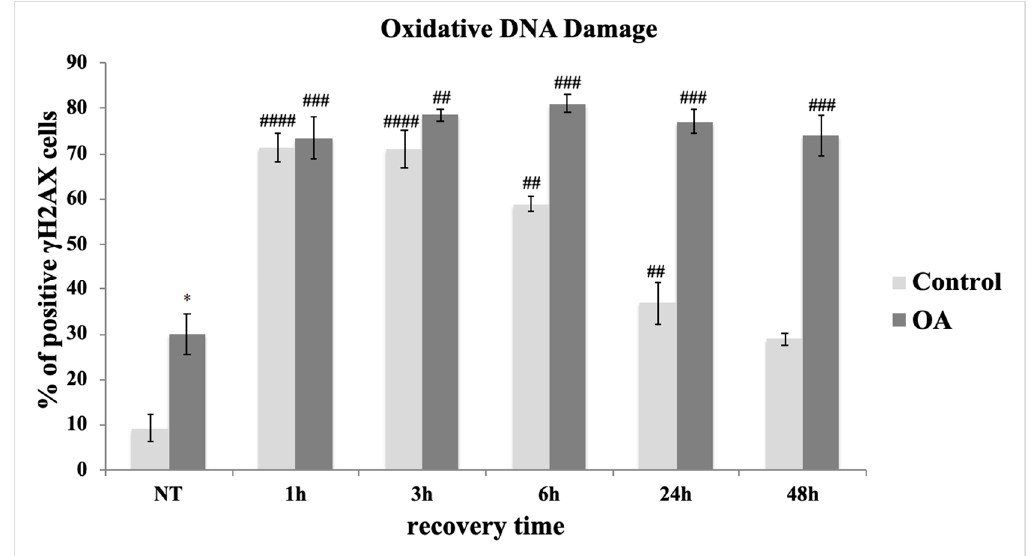
Figure 3. Osteoarthritic chondrocytes fail to repair oxidative DNA damage. Percentages of chondrocytes with DNA damage from three control and three OA patients samples evaluated by staining with the γ H 2 AX antibody under normal conditions (No Treatment—NT) and at different time points of recovery period from the oxidative treatment (1 h, 3 h, 6 h, 24 h, and 48 h). Nuclei bearing > 5 foci stained with γ H2AX were counted as positive. Values shown are the means ± S.E. * p < 0.05 versus control cells and ## p < 0.01, and ### p < 0.001, #### p < 0.0001 versus NT. p values were calculated using the Student t -test.